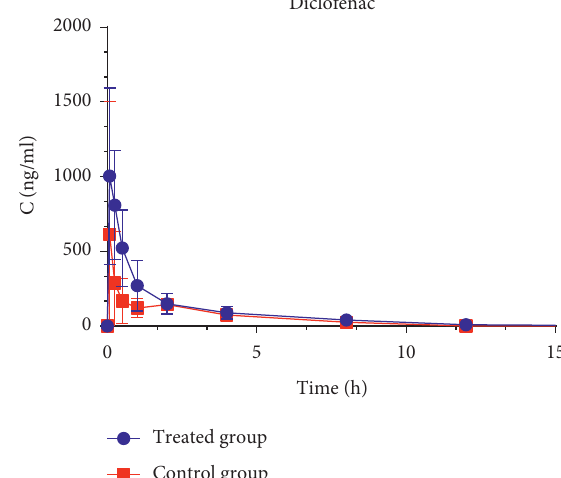
Figure 3: Plasma concentration–time curves of diclofenac in treated group and control group. Six rats in each group were intragastrically given 20mg/kg of LDR (treated group) or identical volume of 0.5% CMC-Na (control group) for fifteen consecutive days, respectively. The two groups were intragastrically given diclofenac prepared in 0.5% CMC-Na at a dose of 2mg/kg at the sixteenth day. Table 6: Pharmacokinetic parameters of diclofenac in the treated group and control group. Pharmacokinetic